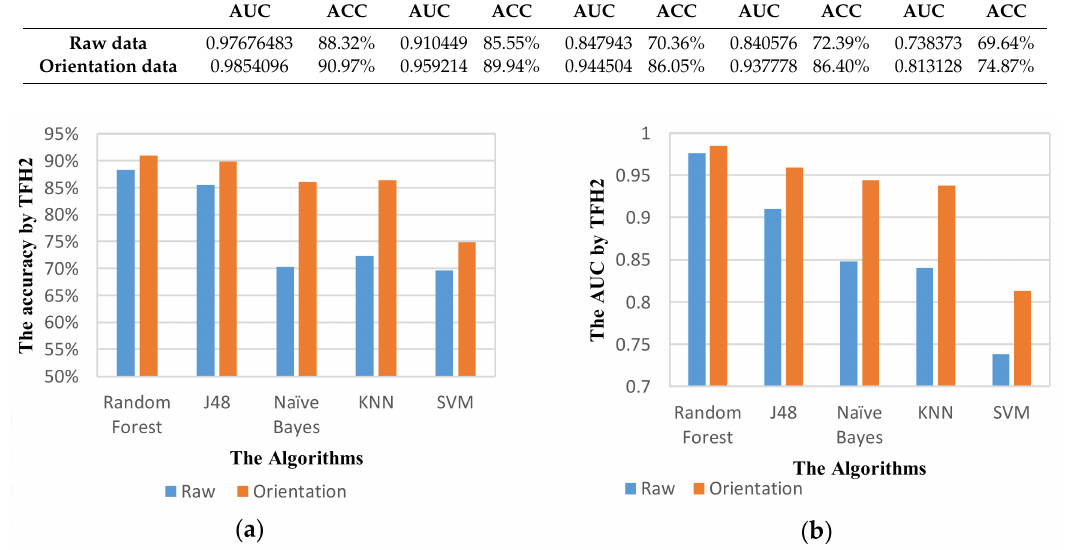
Figure 11. The activity mode detection system performance of different classifiers using raw and transformed data with the window size of 5 s at 50% overlapping on TFH2 feature set based on the metric: ( a ) Accuracy; ( b )